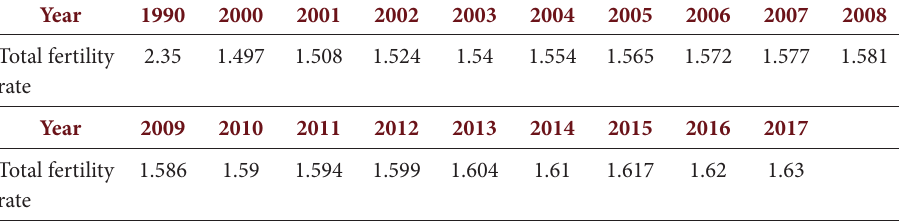
Table 2: Total fertility rate in China, 1990 and 2000–2017.